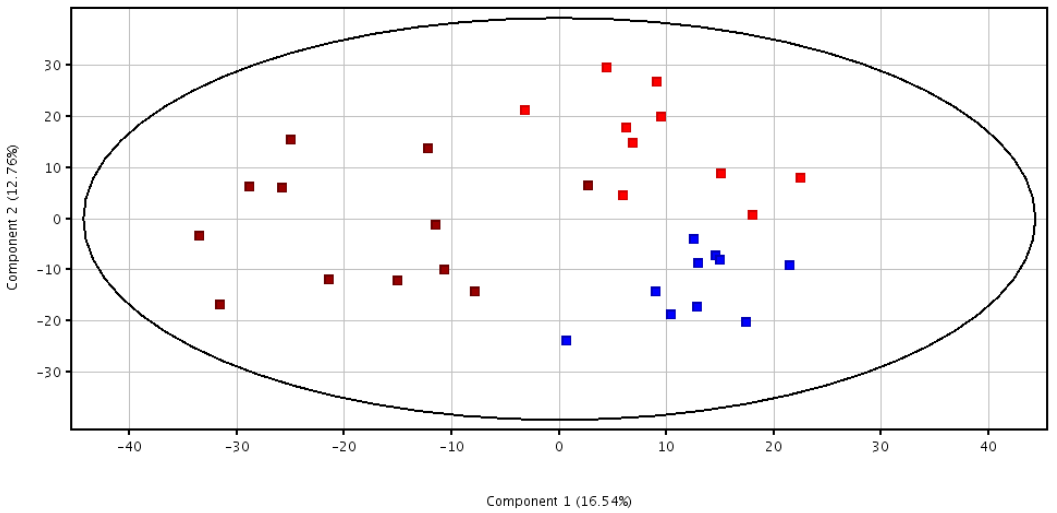
Figure 2. 2D-PCA score plot for serum samples. Red (Group A), blue (Group X), and burgundy (Group A + X) after the 8-months intervention. X-axis represents component 1 (16.54%) and Y-axis is component 2 (12.76%).